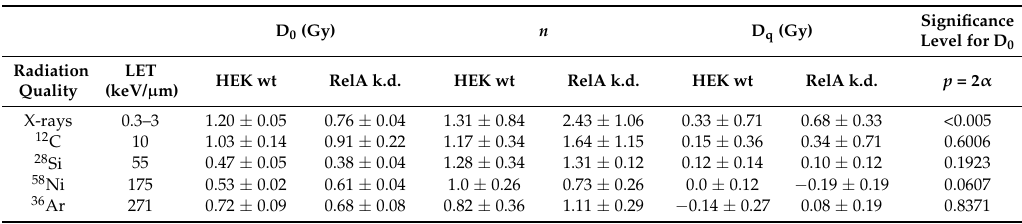
Table 3. Parameters of the survival curves *.